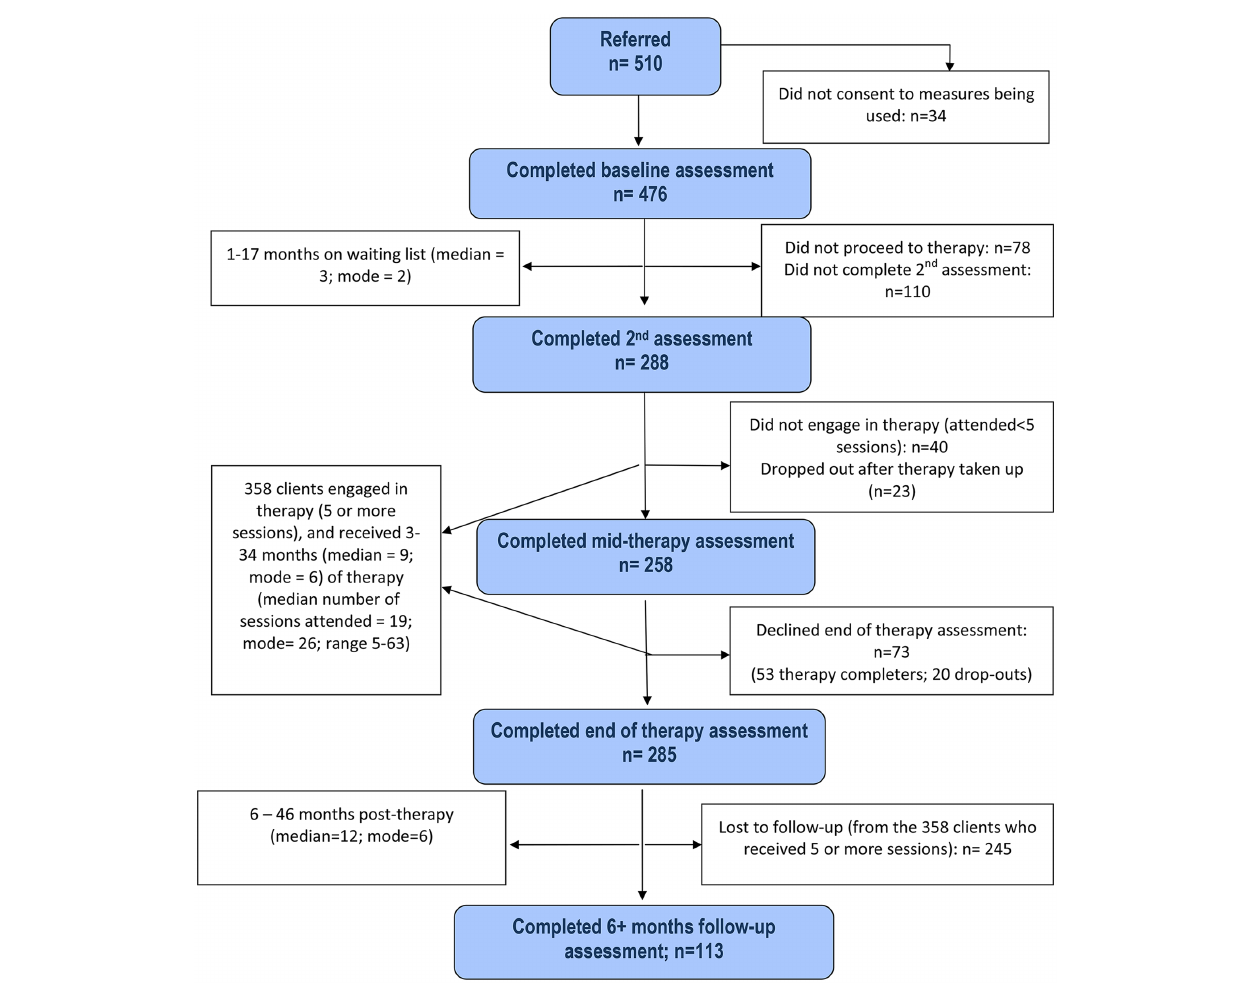
FIGURE 1 | Consort diagram of closed